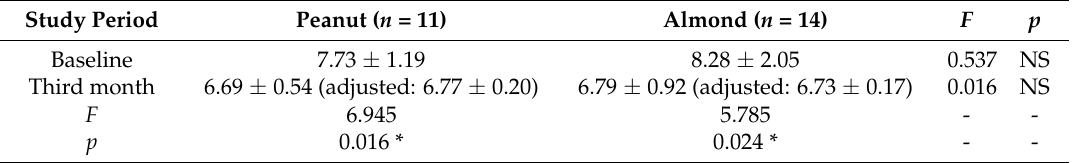
Table 2. Comparison of fasting blood glucose (mmol/L) between the two groups.